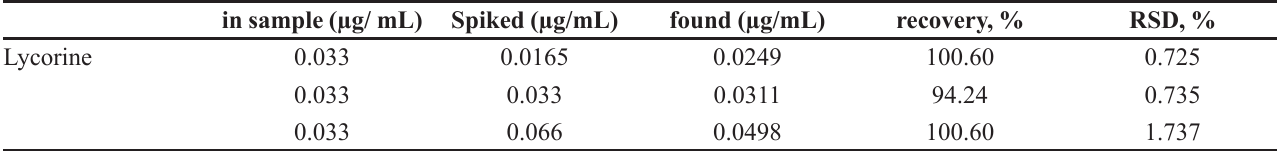
TABLE I - Statistical data showing recovery studies of lycorine (n=3) in sample (µg/